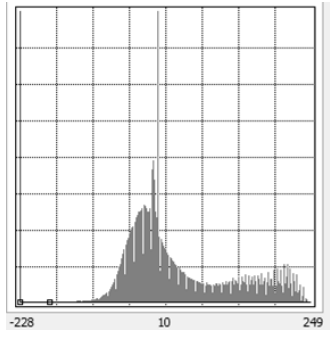
Figure 4. The histogram of difference image In order to enhance the sensitivity of change detection, the value of index N is set to 0.9, and therefore the threshold 1 T =121, 2 T =-33. The differential image is classified according to the threshold and the glacier change detection result image is obtained (Figure 5). The red area in this image is glacier decreased area, while the blue area is glacier increased area.